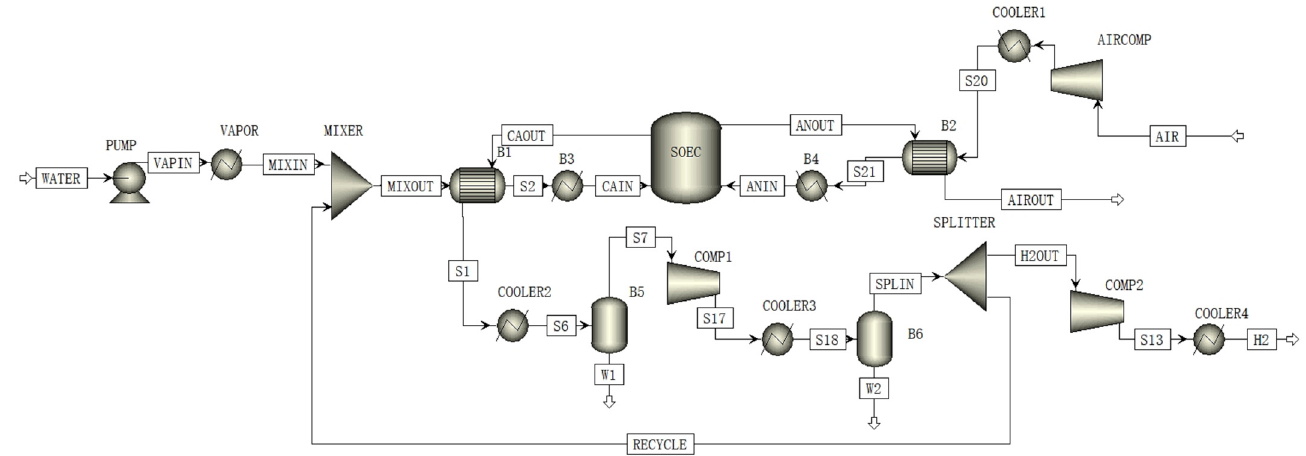
Figure 1 . The process model of HTSE system established by Aspen Plus. Figure 1. The process model of HTSE system established by Aspen